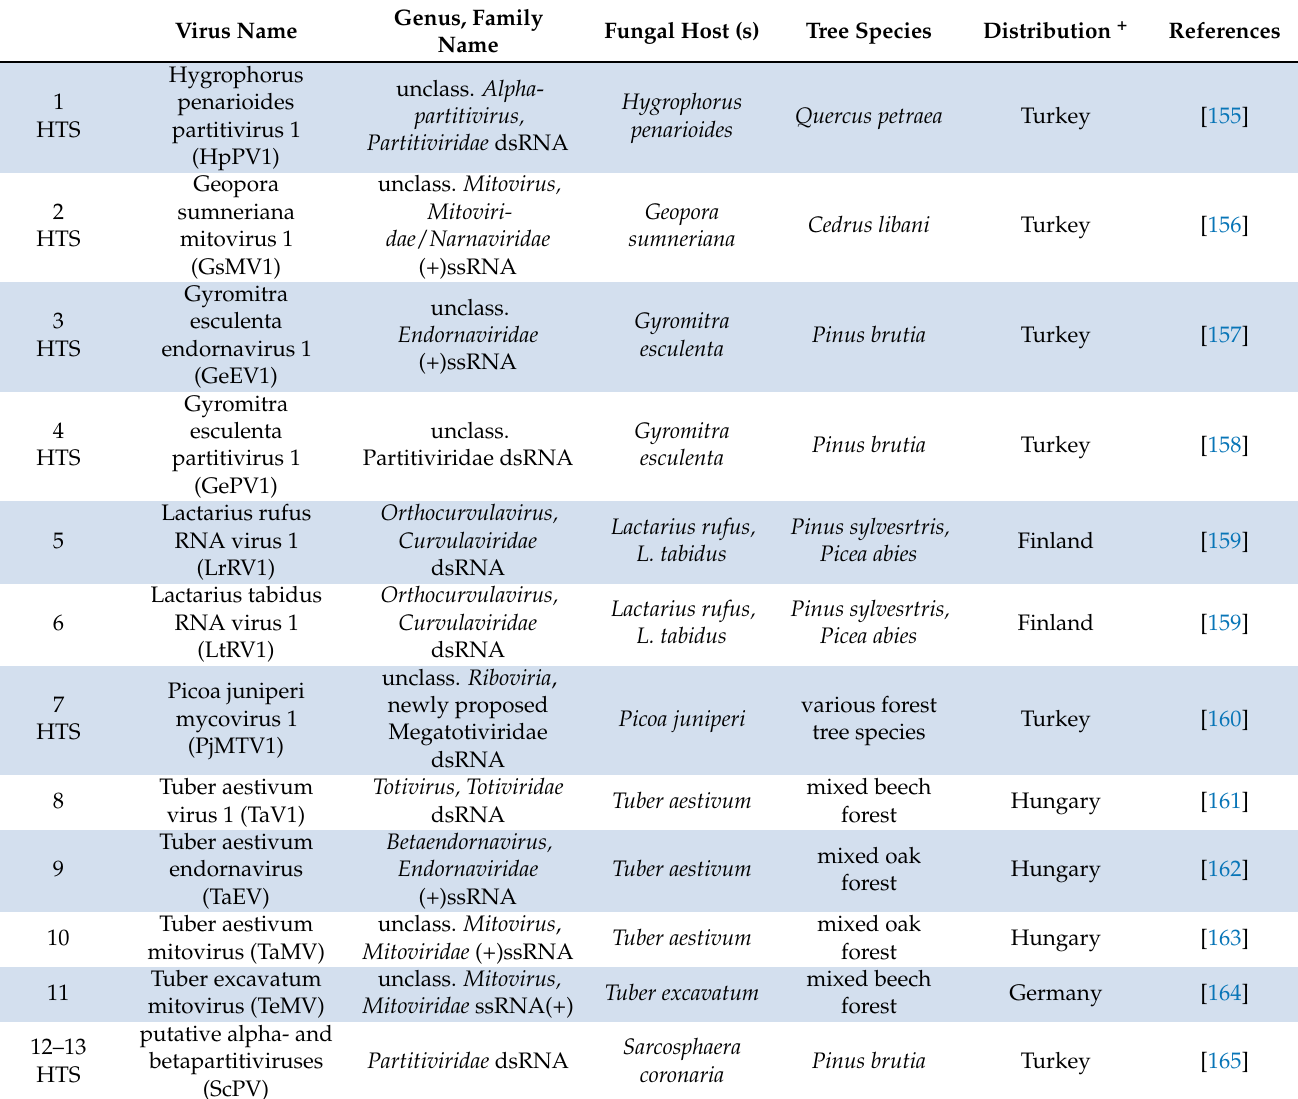
Table 3. Mycoviruses occurring in mutualistic fungi and saprotrophs. For each virus, the virus name, genus and family name, fungal host(s), tree species, countries in which the virus was reported and the related references are given. Numbers in the first column represent ordinal numbers of the listed viruses. Viruses that were discovered by means of HTS methods are indicated by the note “HTS” next to their ordinal